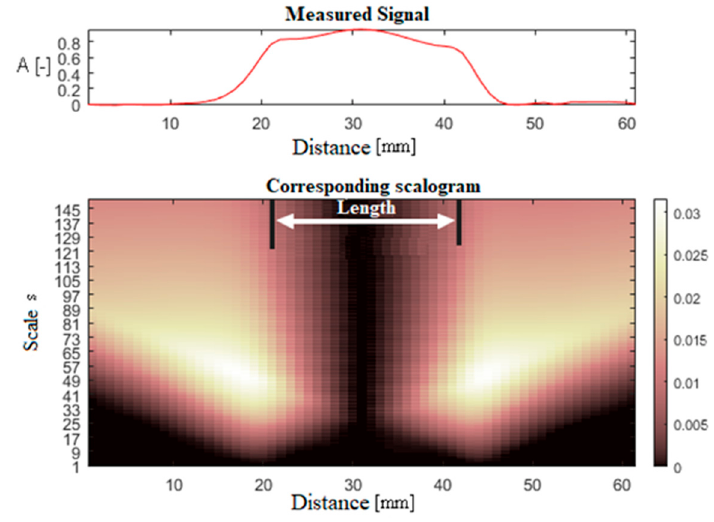
Figure 2. Scalograms for one column of the input data matrix-sample scalogram.